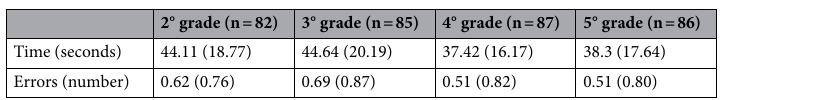
Table 4. Mean execution time (in seconds) and errors (mean and standard deviation) in labyrint one and two of the typical reader sample divided by school